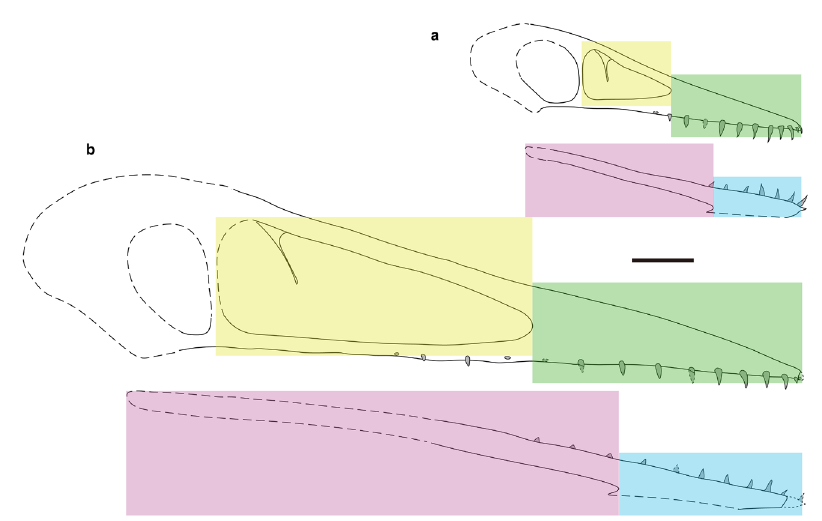
Figure 6. Comparison of the upper and lower jaws between the juvenile and subadult individuals. a, reconstruction based on the juvenile specimen (STM 19- 59); b, reconstruction based on the subadult specimen (IVPP V 23674, Cheng et al. 2017a). The yellow, green, purple, and blue regions indicate approximate areas of the nasoantorbital fenestrae, rostrums, mandibular rami, and mandibular symphyses, respectively. Scale bar, 10